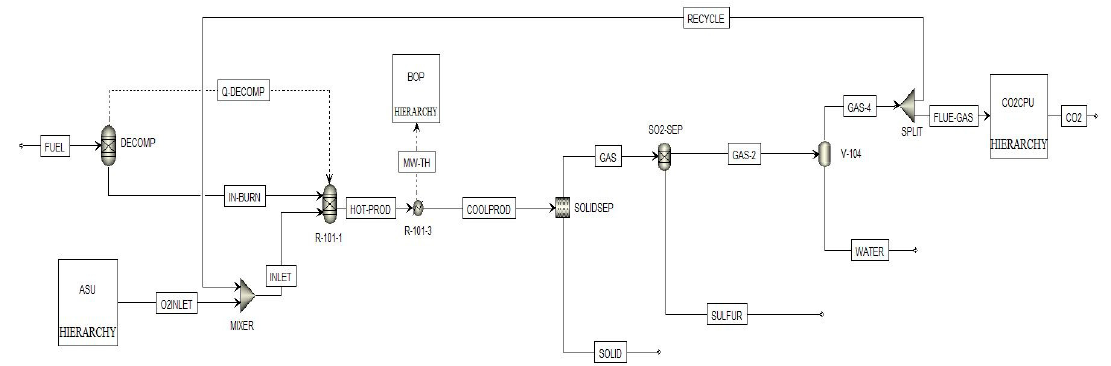
Figure 2. Overall Aspen Plus oxy-combustion flowsheet for coal and petcoke.